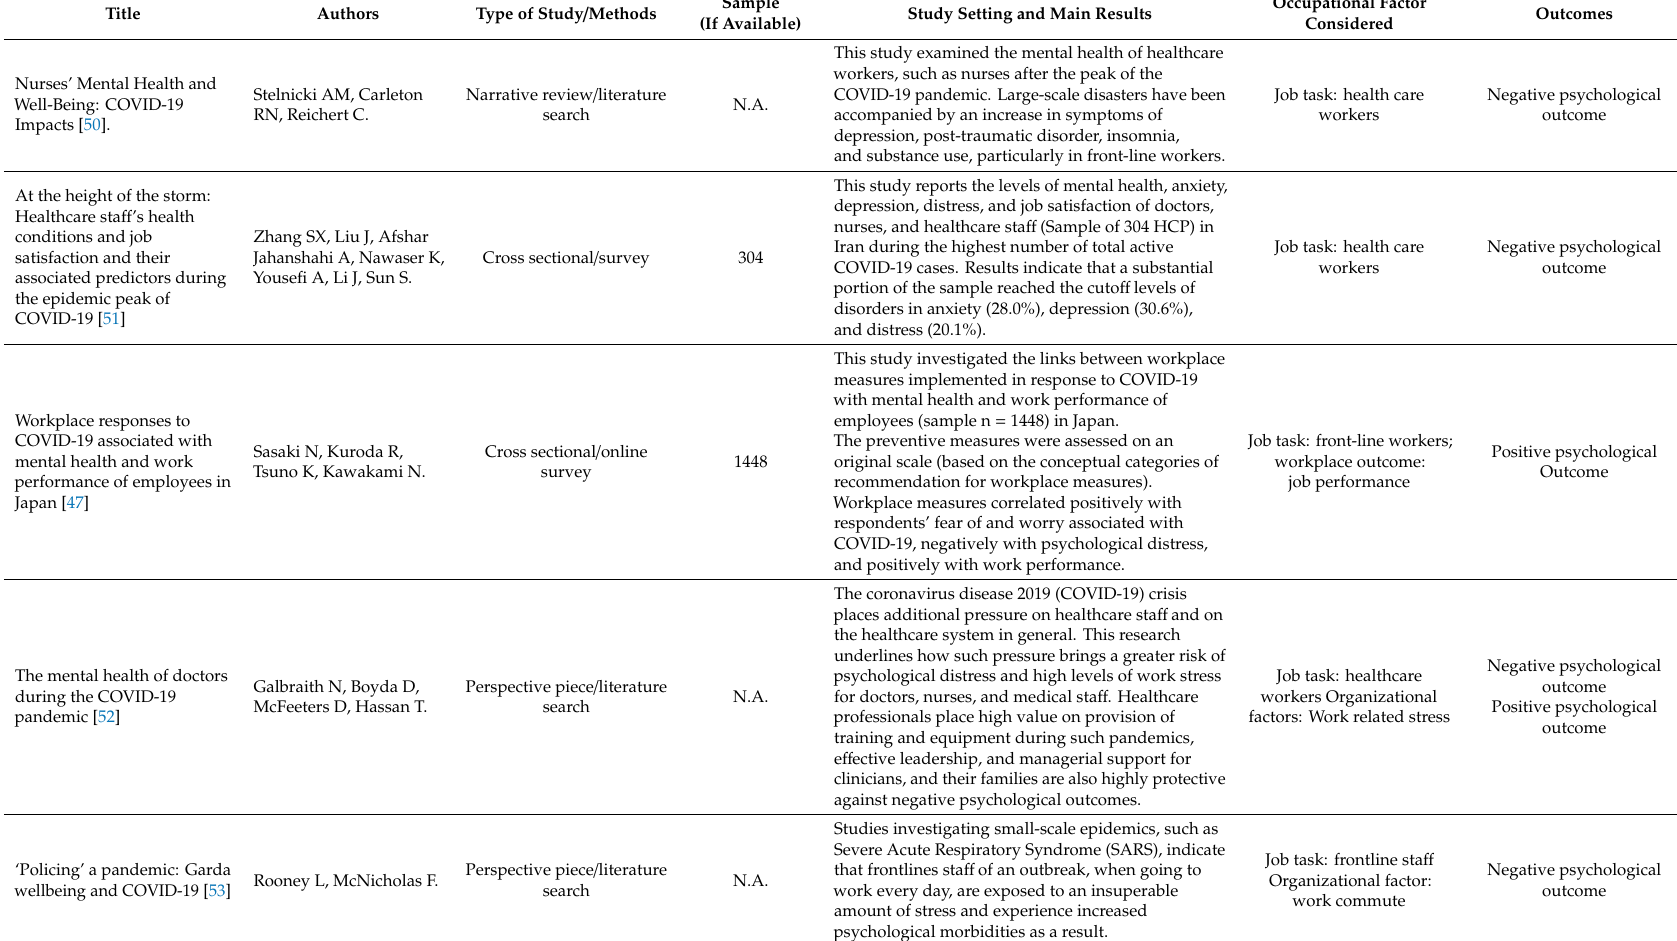
Table 1. Summary of included